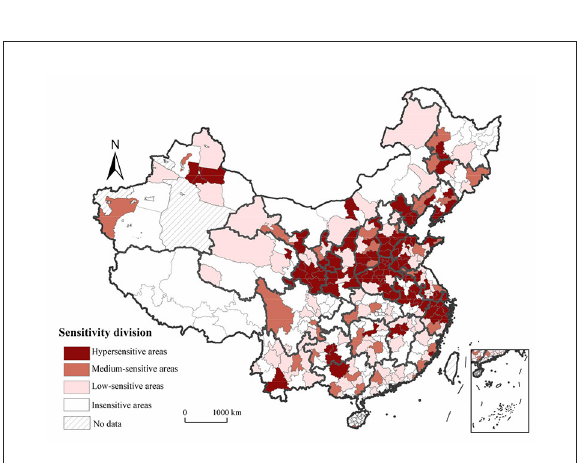
FIGURE8 Sensitivity-based zones relating to the influenza incidence and air pollution in China.